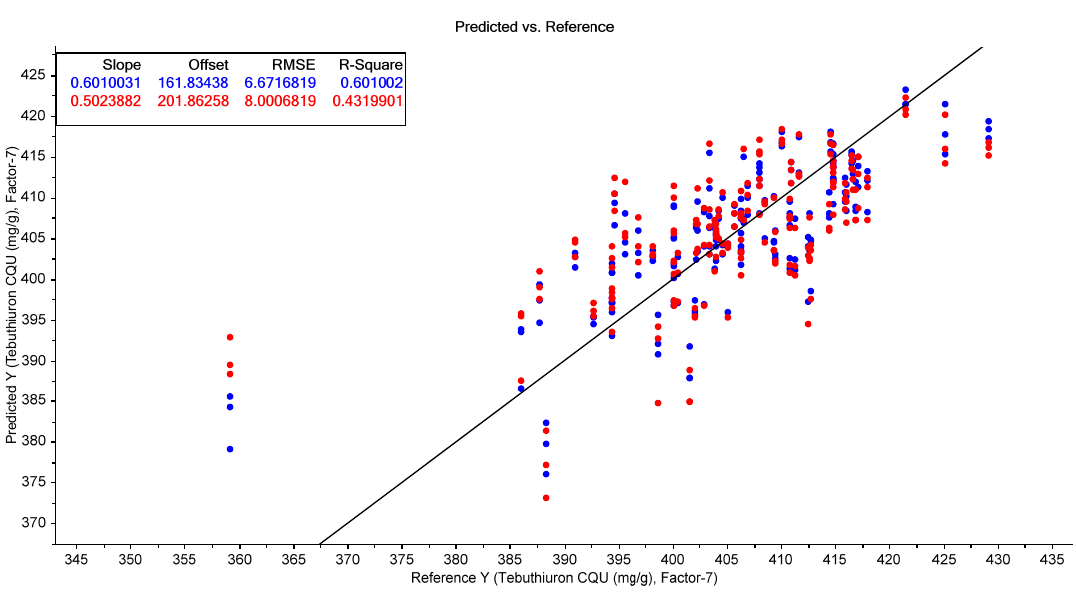
Figure 10. The results of the best-performing PLSR model for the prediction of tebuthiuron content using the FTIR spectra of the powdered Regain400 samples (using SNV pre-processing). The blue points show the model calibration, while the red points show the model cross-validation.